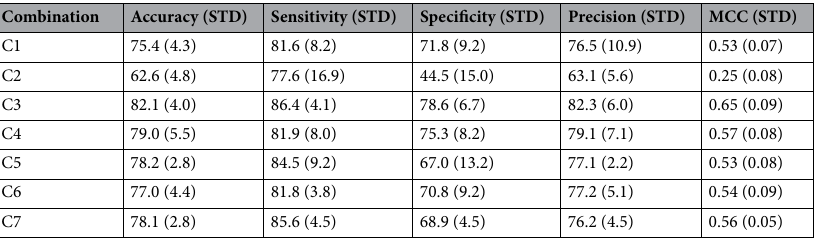
Table 7. Results achieved using fivefold cross validation for ACP-240 dataset (Complete sequences utilized instead of 15 N-terminus amino acids). The STD is also presented in the brackets for each measurement.